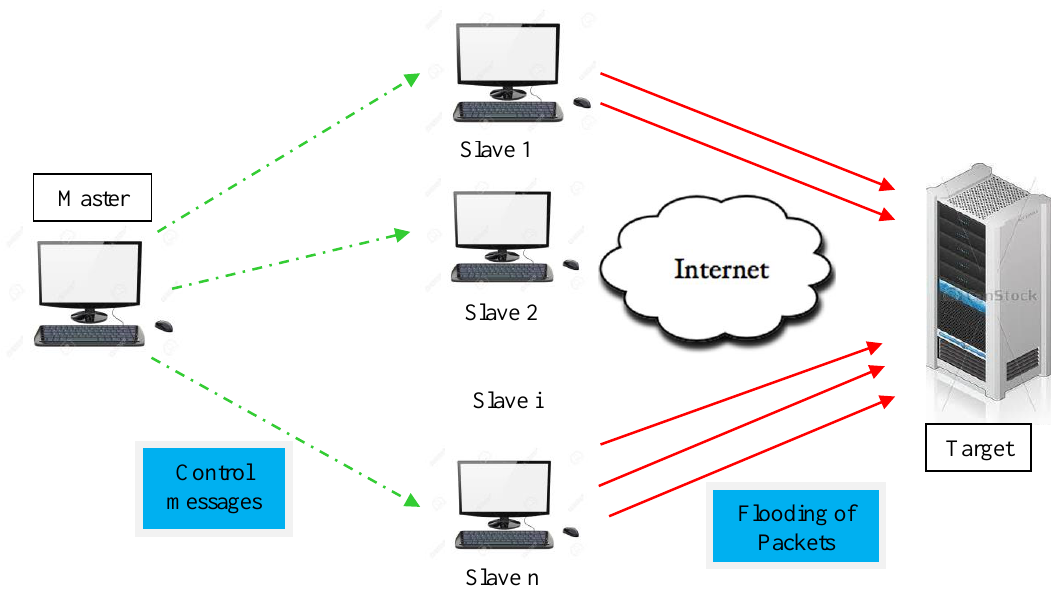
Figure 1. Distributed denial of service attack (Abliz,